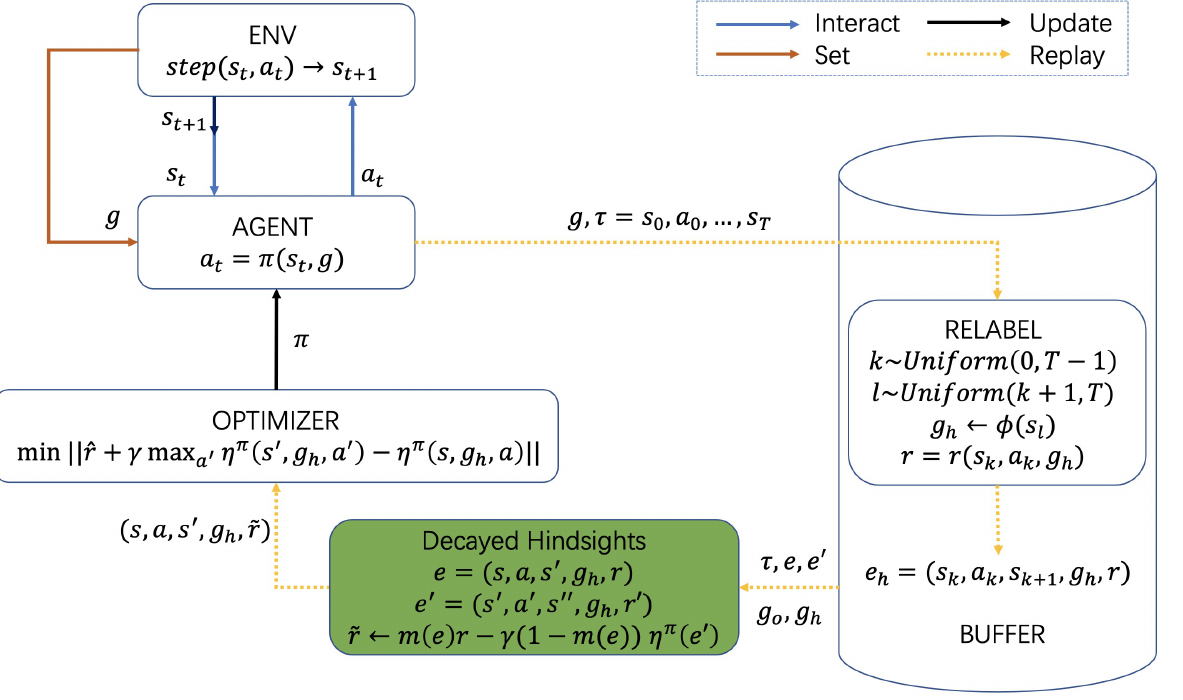
Figure 3. The overall framework for Decayed-HER (on the basis of the vanilla HER). It consists of collecting rollout data and replaying hindsight data. Our proposed DH enables optimized unbiased η π over hindsight experiences with modified hindsight rewards. If this DH module is disabled, it degrades to optimize Q π over hindsight experiences that are biased due to overestimated hindsights. As shown in the framework, the training process runs along each module in a